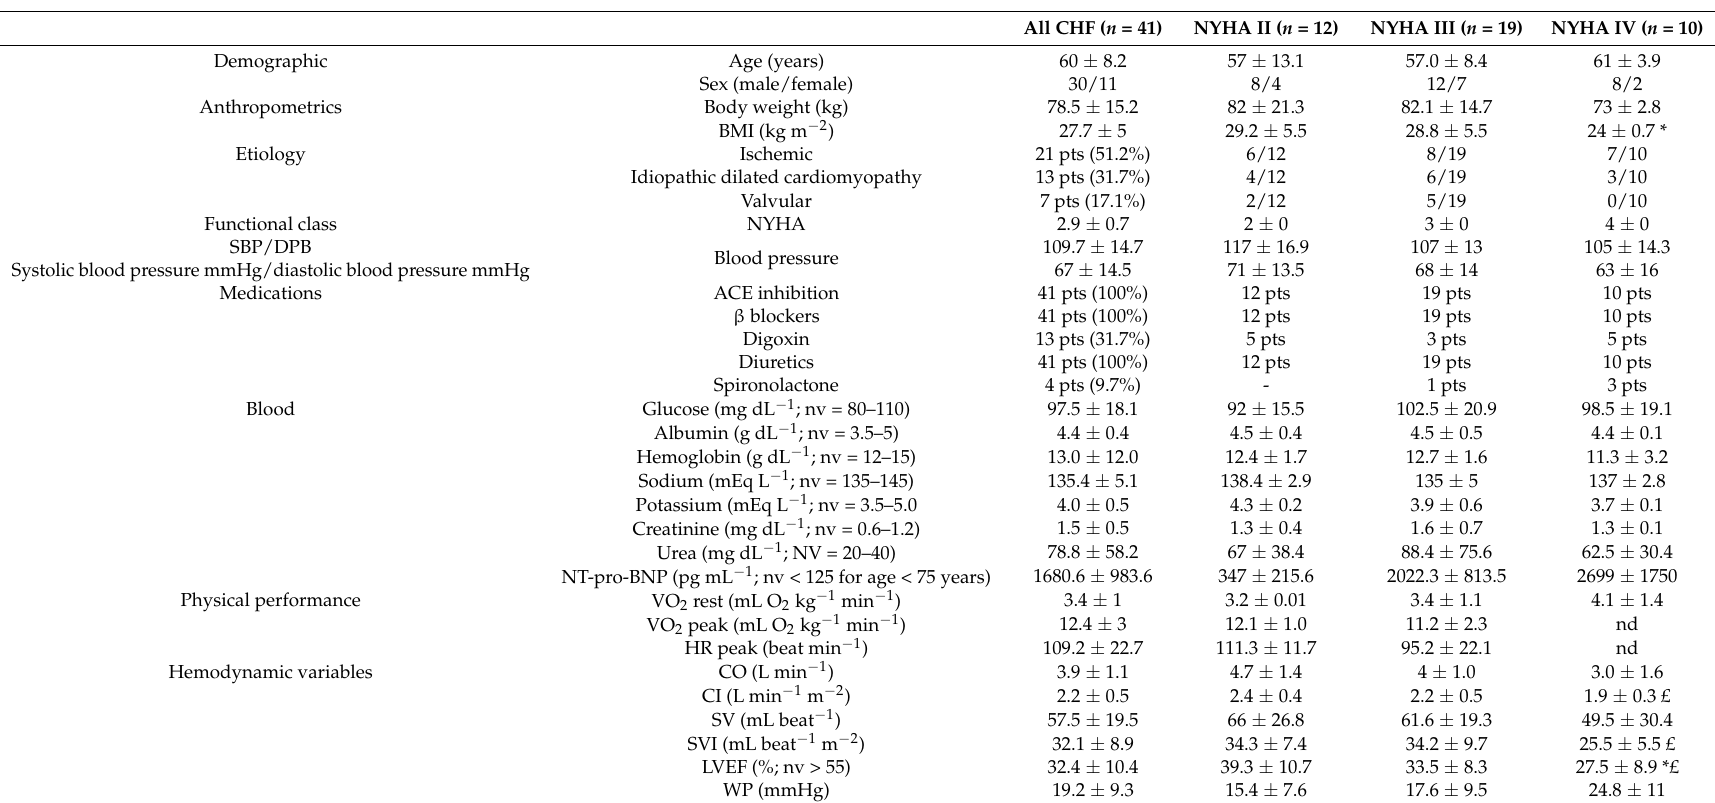
Table 1. Demographic, anthropometric and clinical characteristics, functional class, etiology, biohumeral variables, physical performance (bicycle test), and cardiac hemodynamic variables of the studied CHF